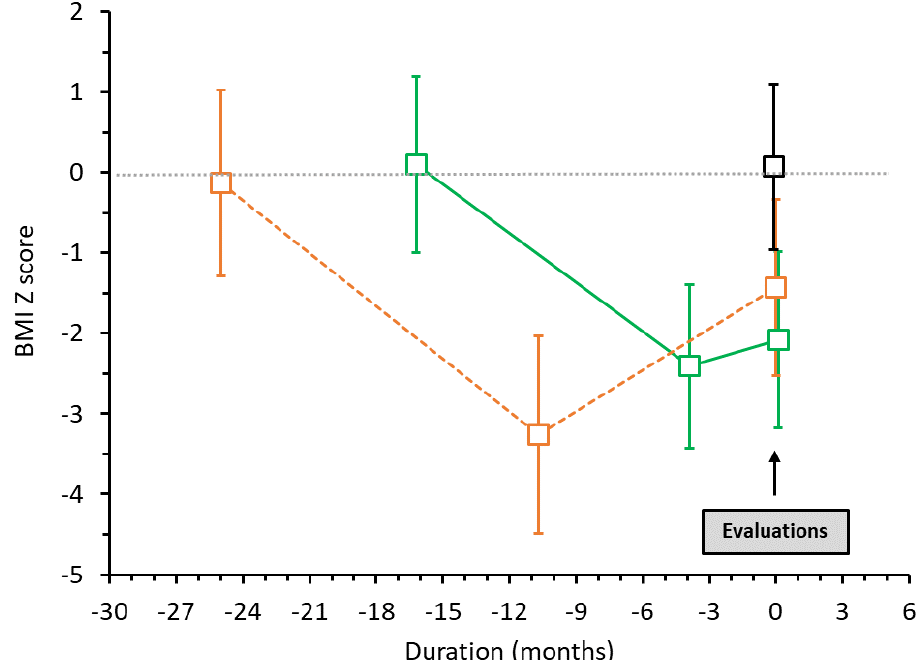
Figure 1. Patterns of the BMI z score from the beginning of the eating disorder in AN patients without WR (in green, solid line) and in AN patients with WR (in orange, dotted line). In black: controls.